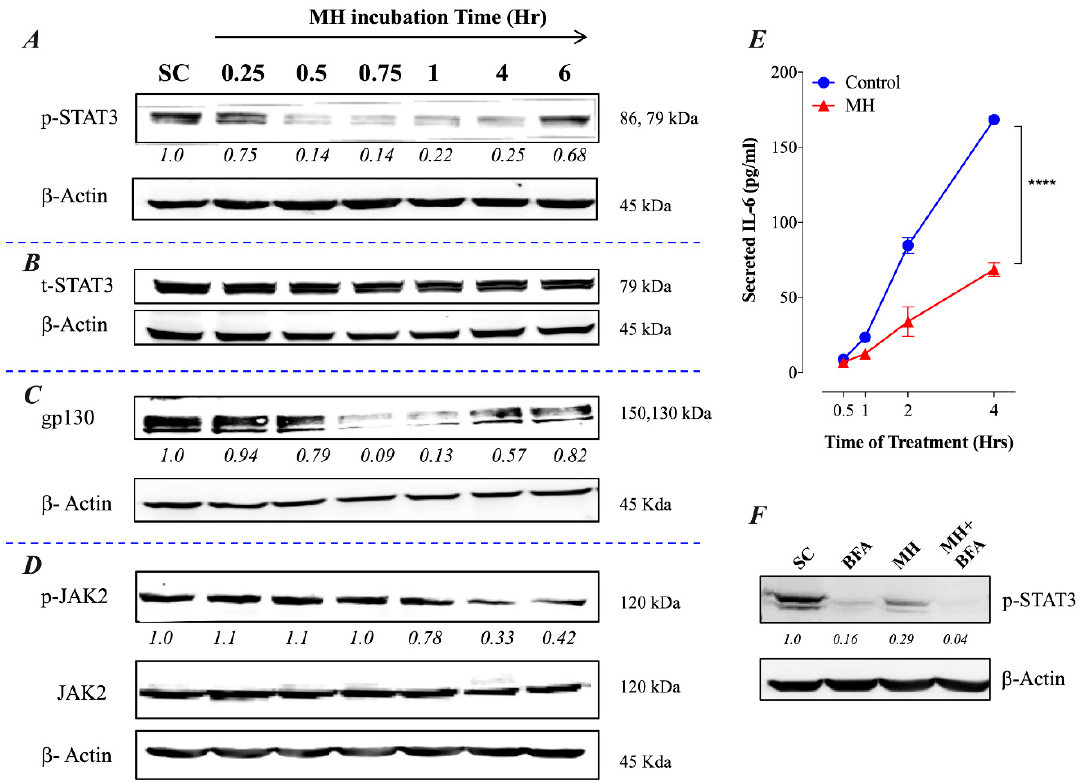
Figure 1. MH inhibits the IL-6 receptor signaling pathway in breast cancer cells. MDA-MB-231 cells were exposed to 1% MH, or an equivalent sugar control (SC) solution for the indicated times and analyzed by Western blotting for the relative protein expression of tyrosine-phosphorylated p-STAT3 ( A ), total STAT3 ( B ), gp130 ( C ), and JAK2 / p-JAK2 ( D ). β -actin was used as a loading control. ( E )